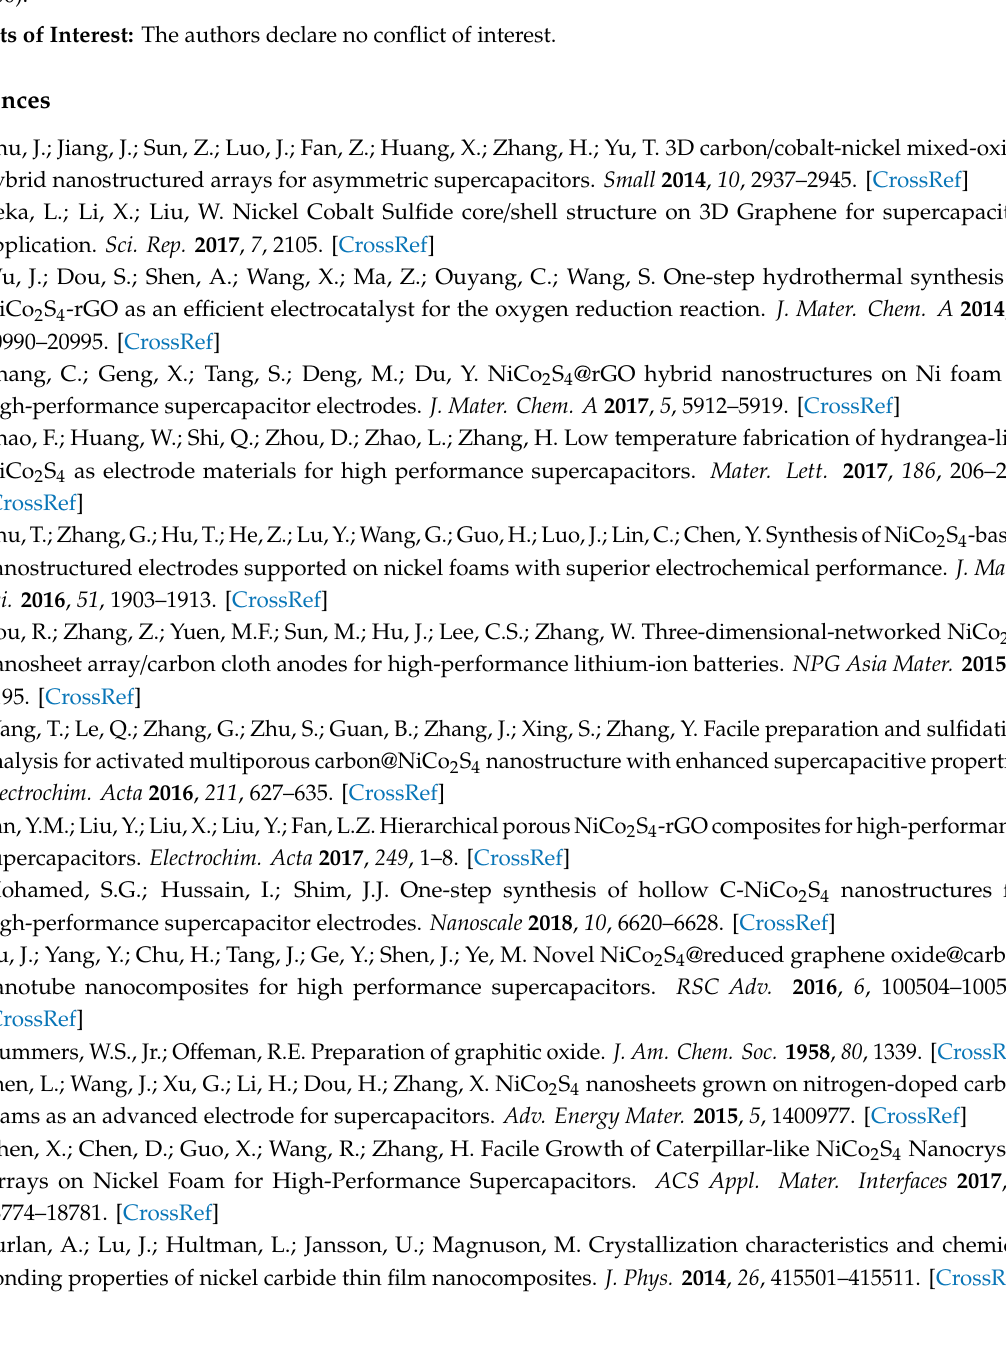
Figure S1: Characterizations of the Ni-rGOs, Figure S2: XPS survey scan of the NiCo 2 S 4 / Ni-rGO nanocomposites, Figure S3: Characterizations of the NiCo 2 S 4 / rGO nanocomposites without doping of Ni ions on the surface of the